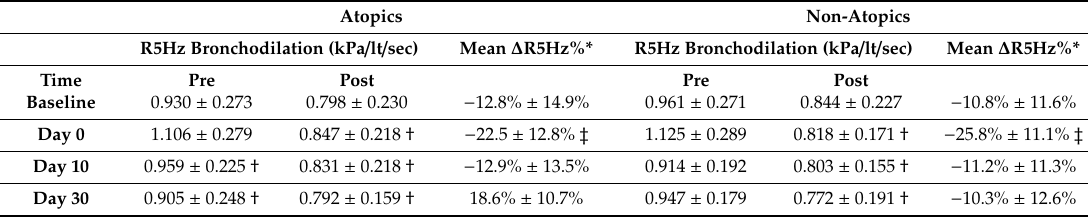
Table 2. Mean R5Hz pre- and post-bronchodilation in atopic and non-atopic children and percentage of response to bronchodilation: baseline and day 0, 10, and 30 from the beginning of the wheezing episode .